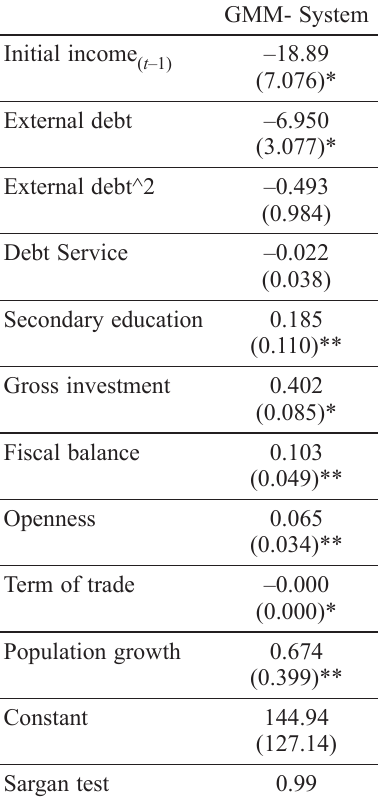
Table 2. Debt-Laffer curve of growth